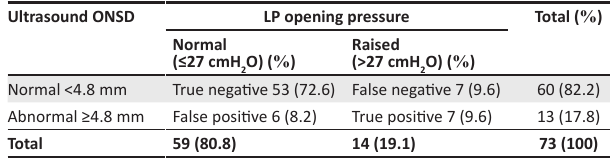
TABLE 1: Ultrasound optic nerve sheath diameter (ONSD) measurements compared with lumbar puncture (LP) opening pressure. Ultrasound ONSD